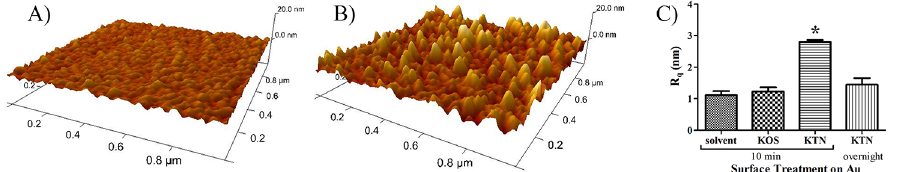
Fig 3. Layer roughness. Gold surfaces treated with A) solvent only (10 mM NaOH) and with KOS (oxidized keratin) solution have relatively smooth profiles compared to those with B) KTN (reduced keratin) extract. C) Partial surface adsorption of KTN increased the roughness, Rq, whereas full coverage by overnight KTN incubation led back to a smoother surface. * p < 0.05 compared to each of the other groups.